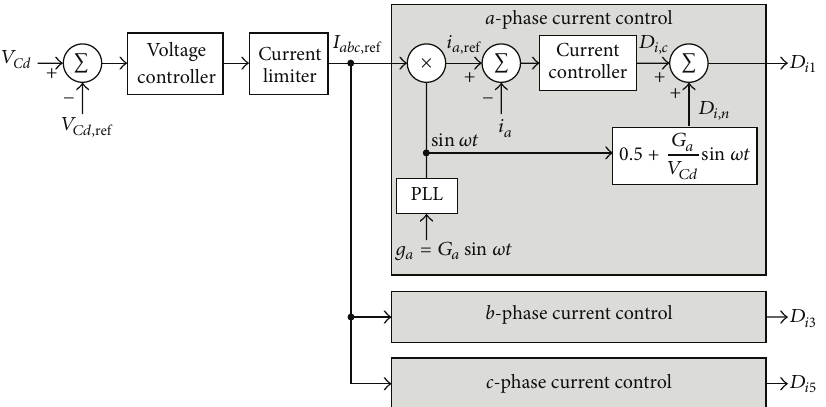
Figure 4: Control-block diagram of the inverter/rectifier at the grid-connected inverter and rectifier modes.